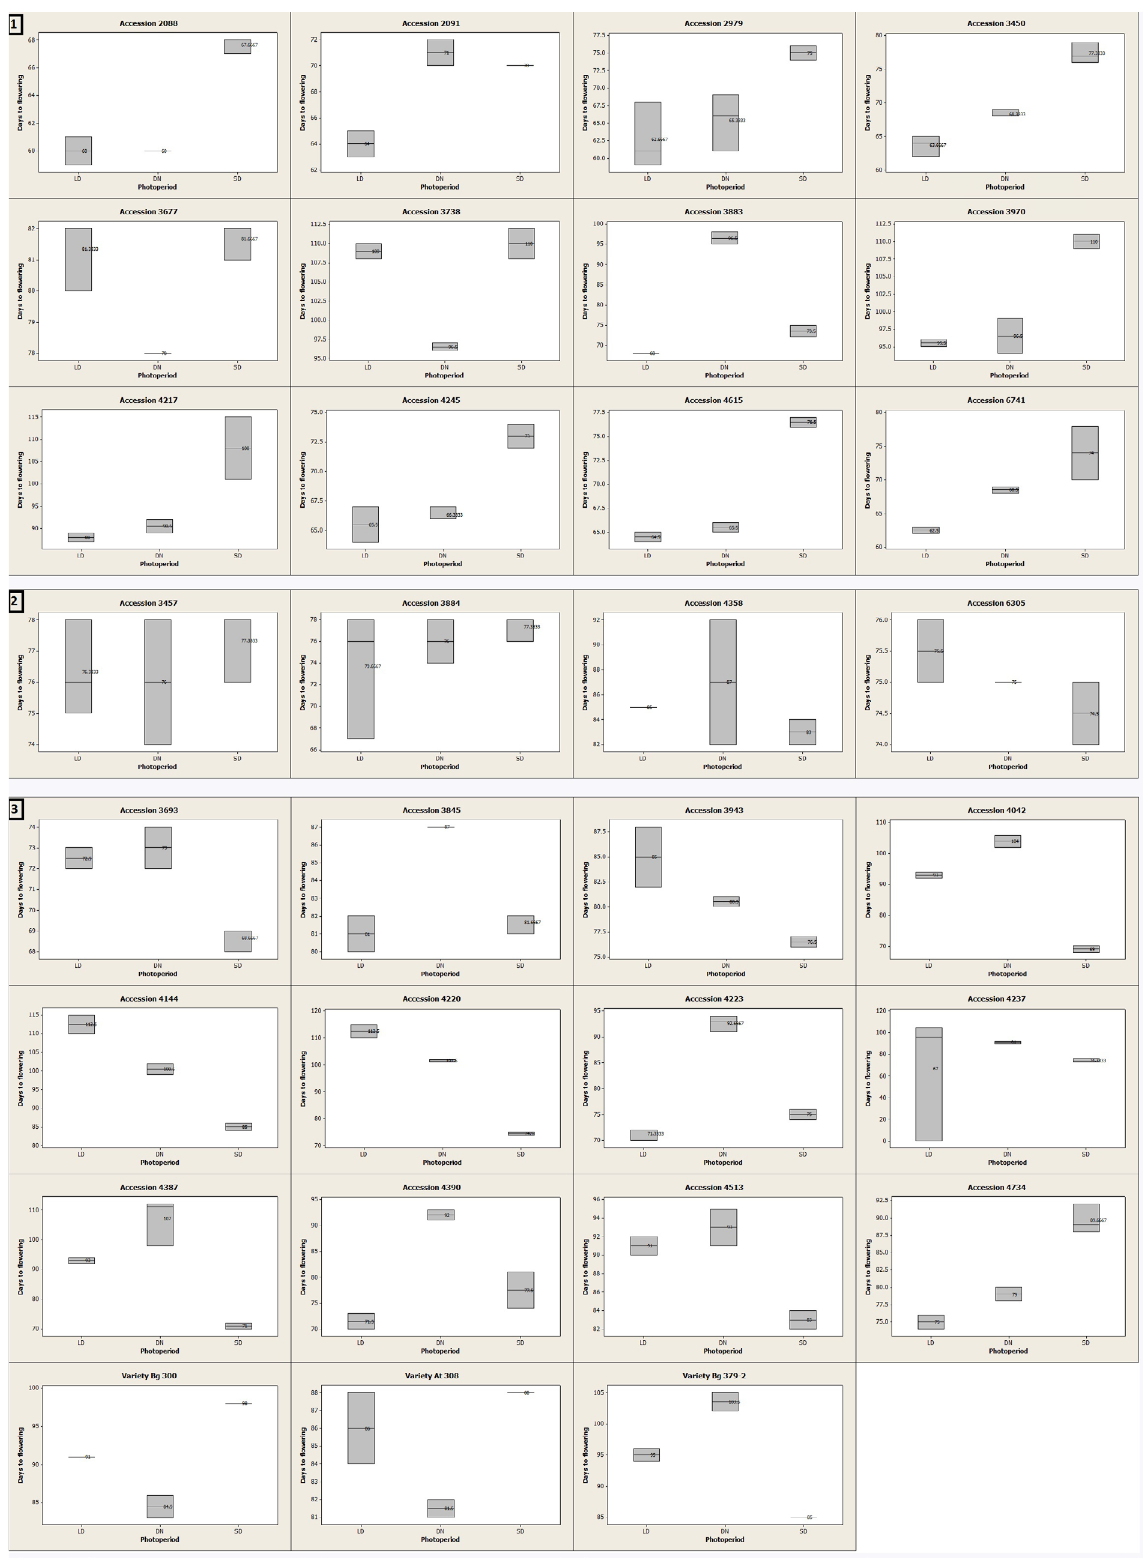
Figure 1: Effect of photoperiod on a variety of days to flowering responses among Sri Lankan very early maturing rice accessions: 1) Twelve accessions flowered significantly late under SD condition over LD condition or DN condition; 2) Four accessions didn’t respond to photope- riod for flowering time; 3) Fifteen accessions flowered significantly early under SD over